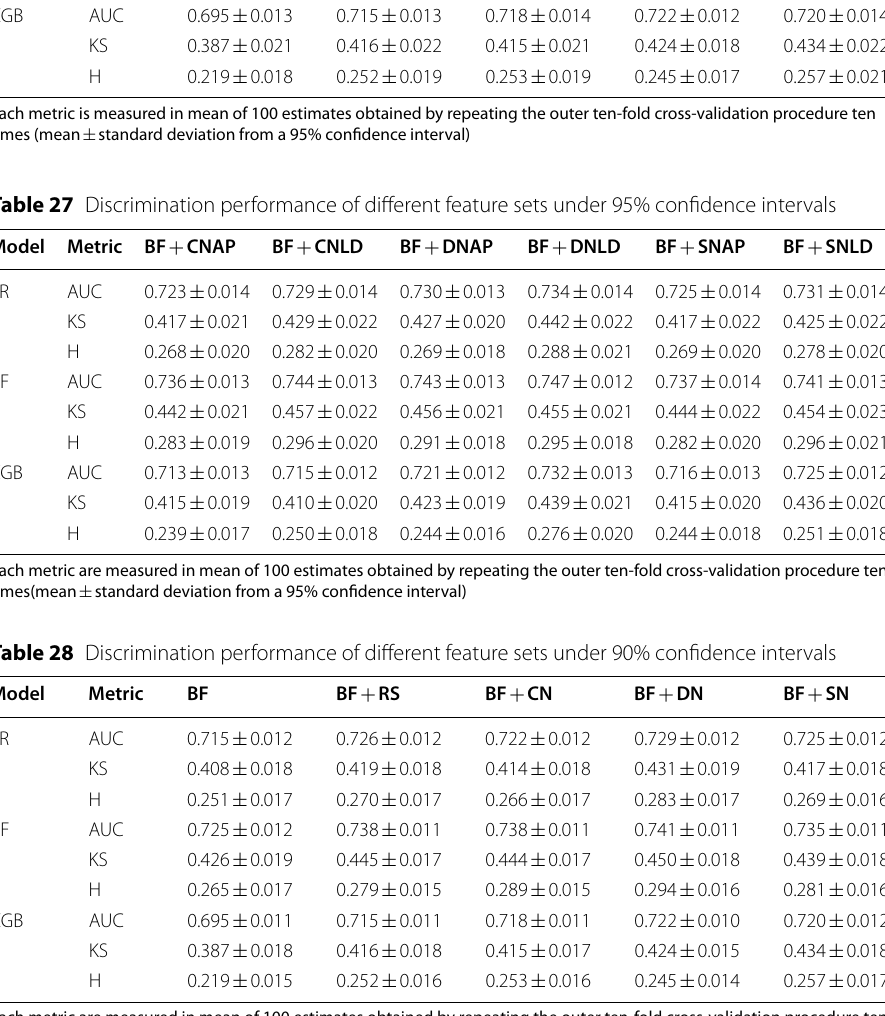
Each metric are measured in mean of 100 estimates obtained by repeating the outer ten-fold cross-validation procedure ten times (mean standard deviation from a 90% confidence ±